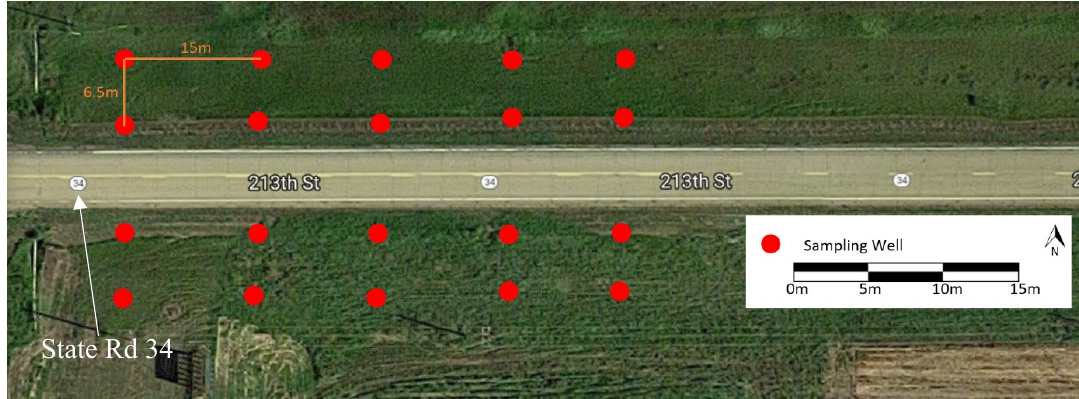
Figure 2. Leachate sampling well in roadside ditches ( a ) during installation and ( b ) after installation.